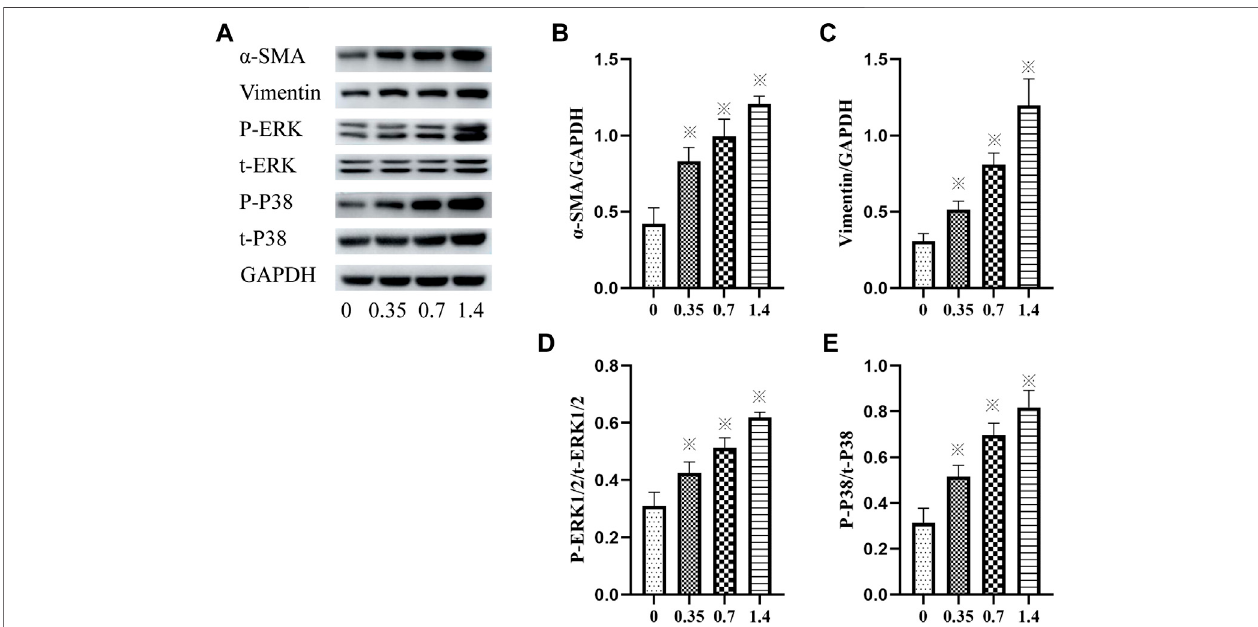
FIGURE3|(A – E) : α -SMA,vimentin, p-ERK1/2, ERK1/2,p-p38and p38levels inHELFsweredetected using Western blotting.Cellswereincubated withdifferent concentration of VCR (0, 0.35, 0.7 and 1.4 μ g/ml) for 24 h. Data were presented as mean ± SEM from three independent experiments. * p < 0.05 vs . the control group. (A – D) : 0,0, 0.35,0.7 and 1.4 μ g/ml VCR